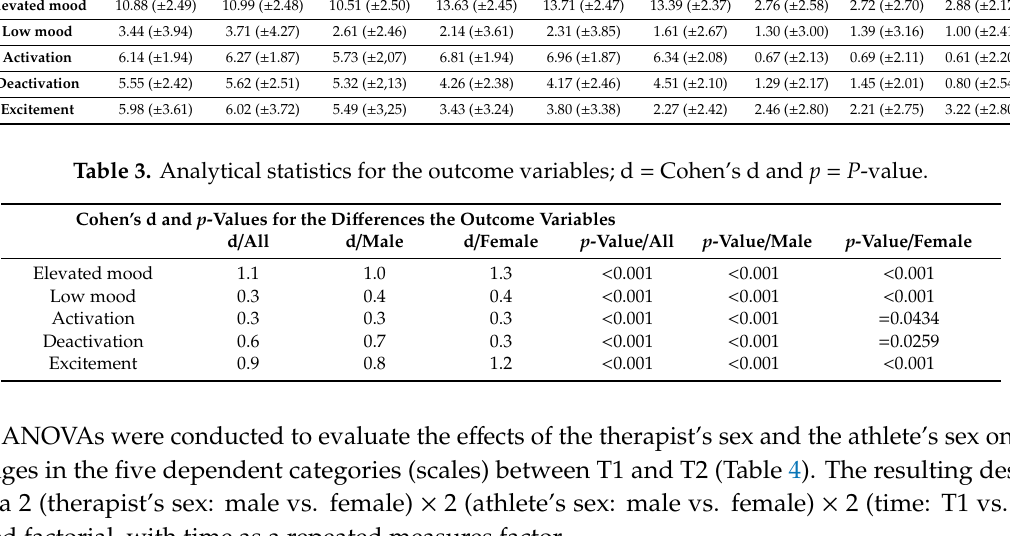
Table 2. Descriptive data for the outcome variables. Mean value (standard deviation) and Di ff = di ff erence. Category